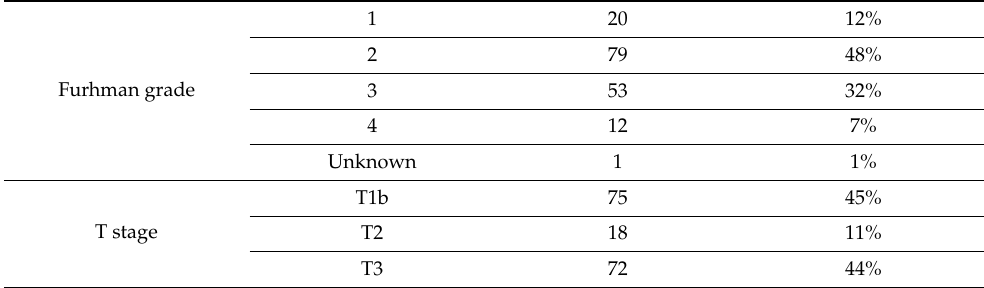
Table 1. Clinical Characteristics of the